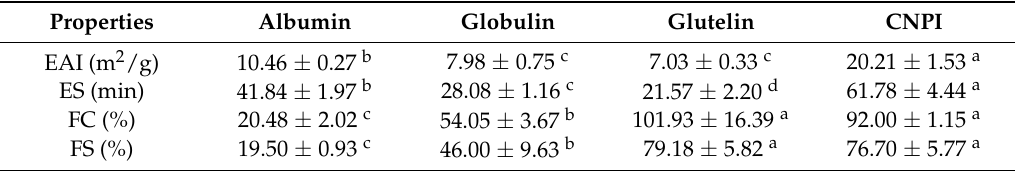
Table 5. Emulsifying and foaming properties of cashew nut protein fractions compare with CNPI in neutral